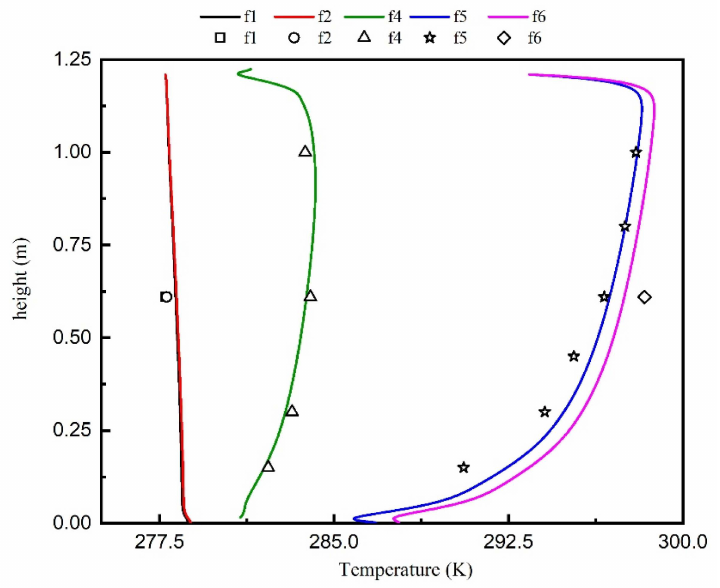
Figure 15. Experimental and numerical temperature profiles for the three glazings, according to k-w models, P = 190 W.m − 2 .